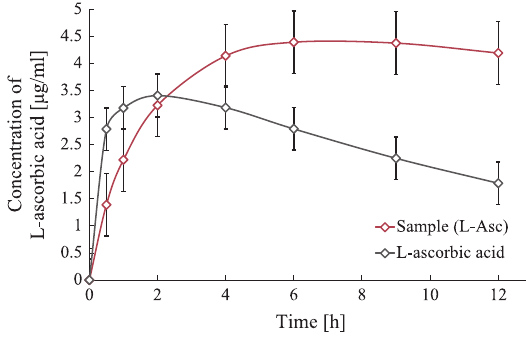
Fig. 12 Time evolution of L-ascorbic acid concentration released from a sample (L-Asc) and bare specimen after UV irradiation for 12 h. Re- printed with permission from Ref. (Tominaga et al., 2018). Copyright: (2018)